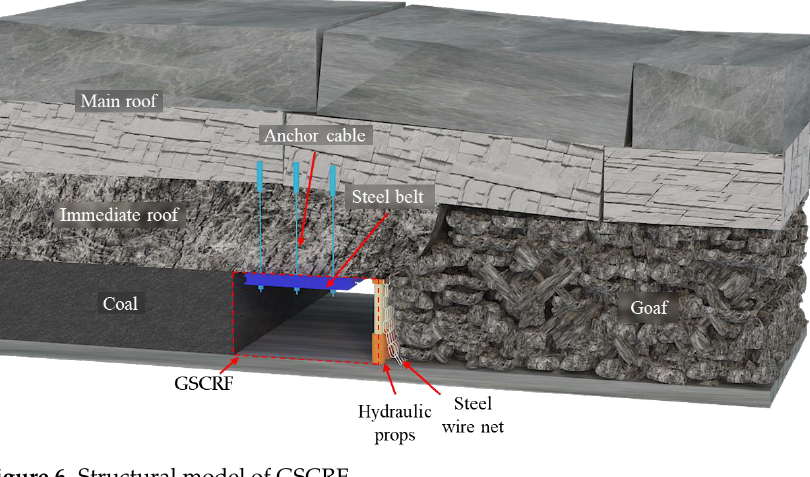
Figure 6. Structural model of GSCRF.